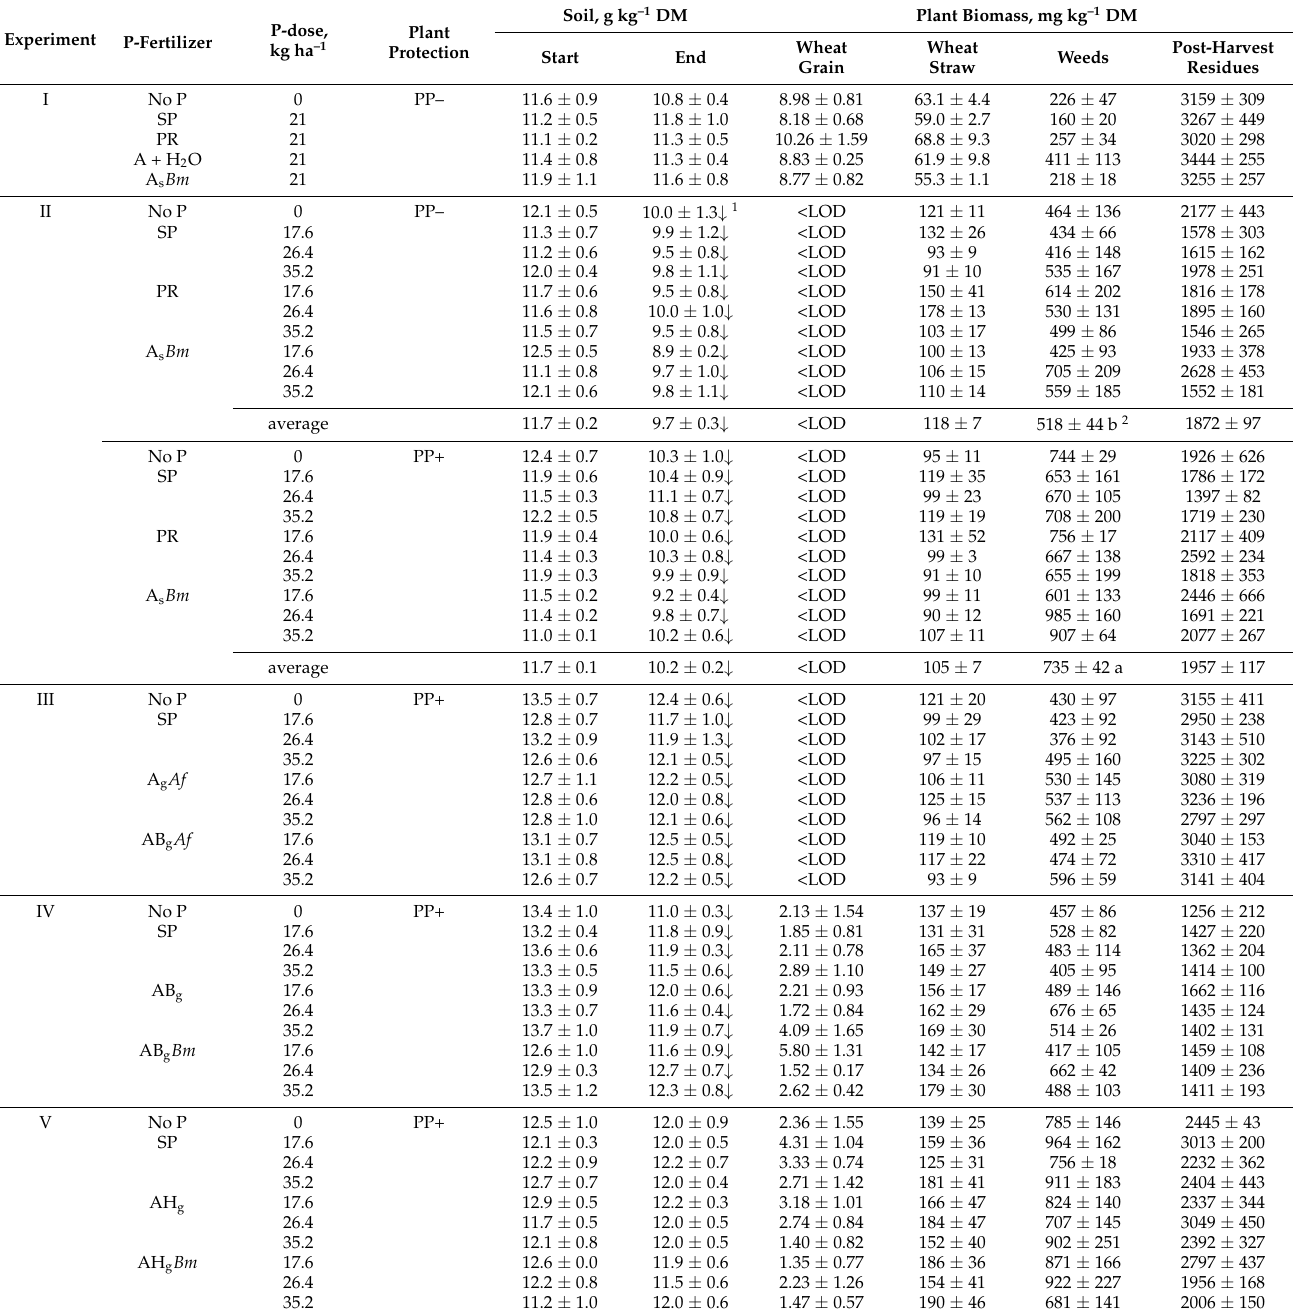
Table 4. Total Al content in soil and plant biomass (average ± standard